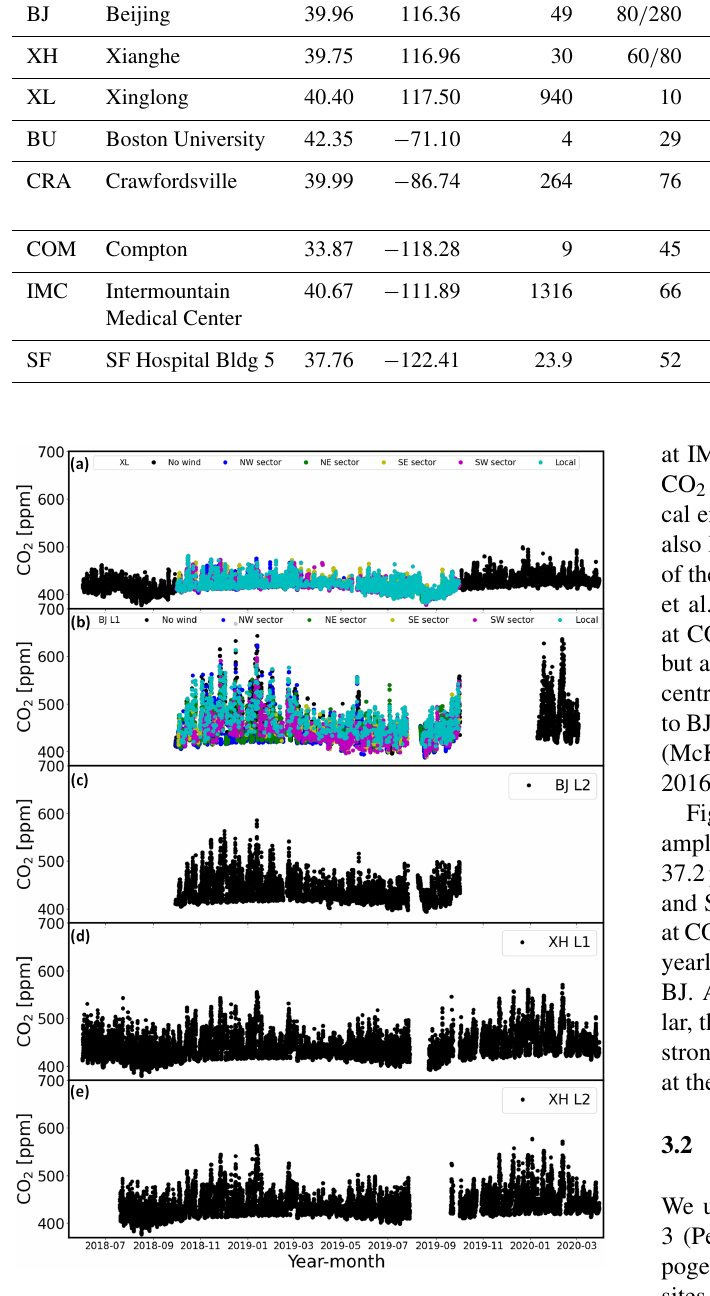
Figure 4. The time series of the CO 2 measurements at XL (a) , BJ L1 (b) , BJ L2 (c) , XH L1 (d) , and XH L2 (e) between June 2018 and March 2020. The CO 2 measurements at XL (a) and BJ LI (b) are colored by wind classes discussed in the